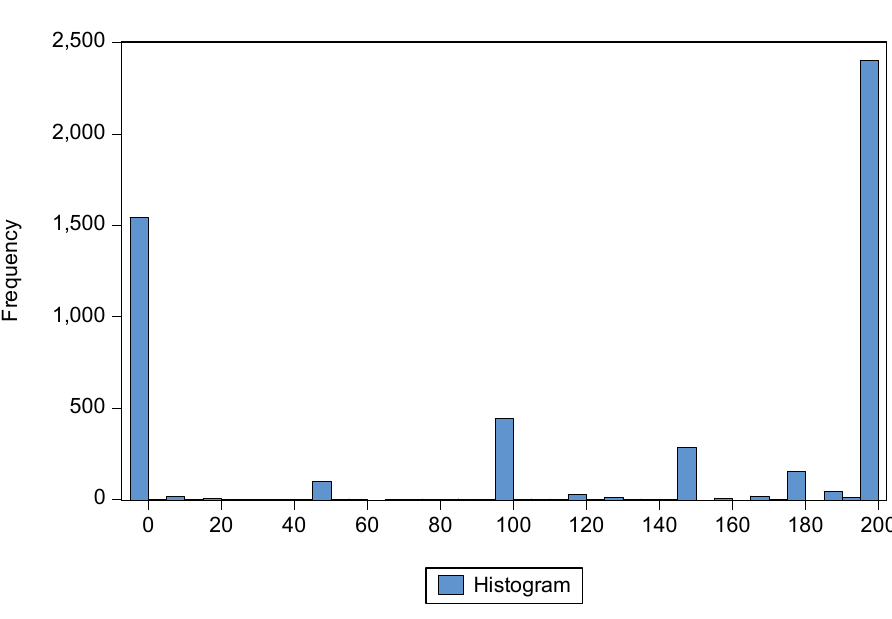
Figure 6. Distribution of tax payments, all participants. Source: Own calculations.